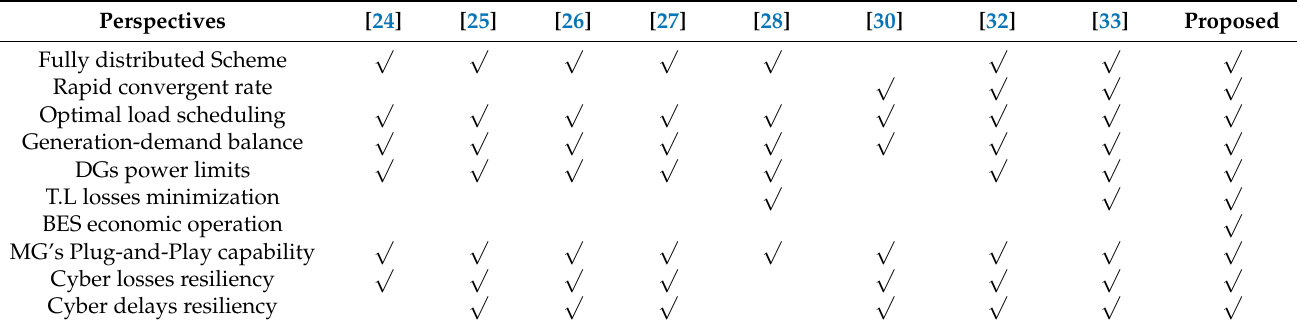
Table 1. Comparison of the Existing Power Management Control Strategies of DC Microgrids